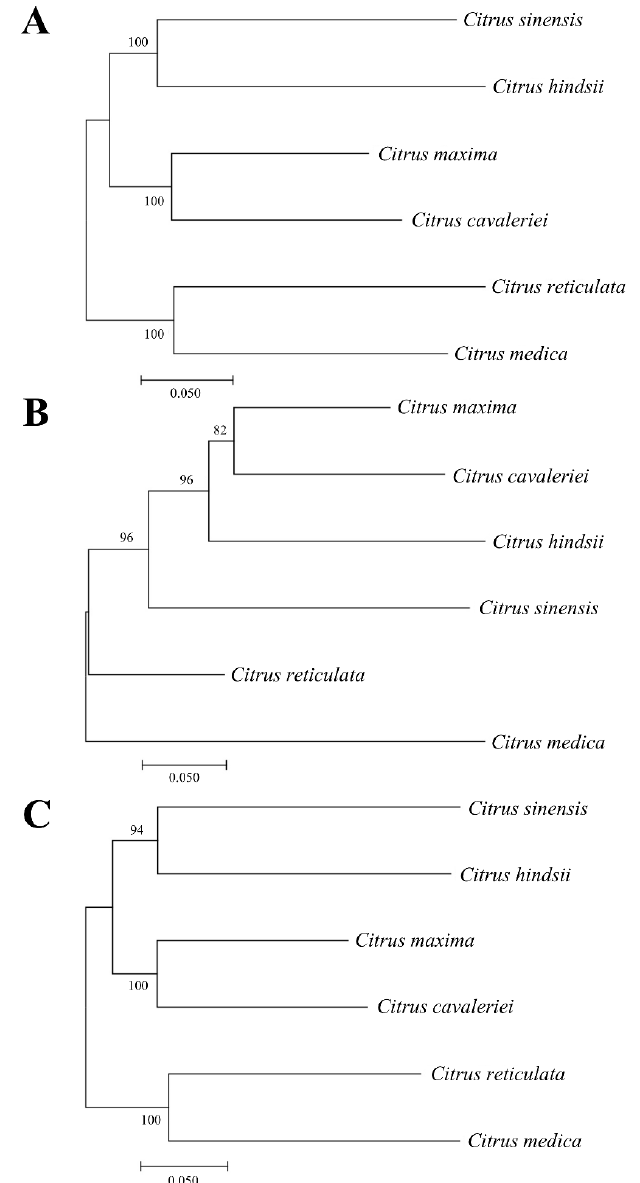
Figure 3. Phylogenic tree constructed based on the common 5UI and 3UI sequences. ( A – C ) Phylogenic tree constructed based on the tandom 81 common 5UI sequences, 26 common 3UI sequences and all the common UIs, respectively.